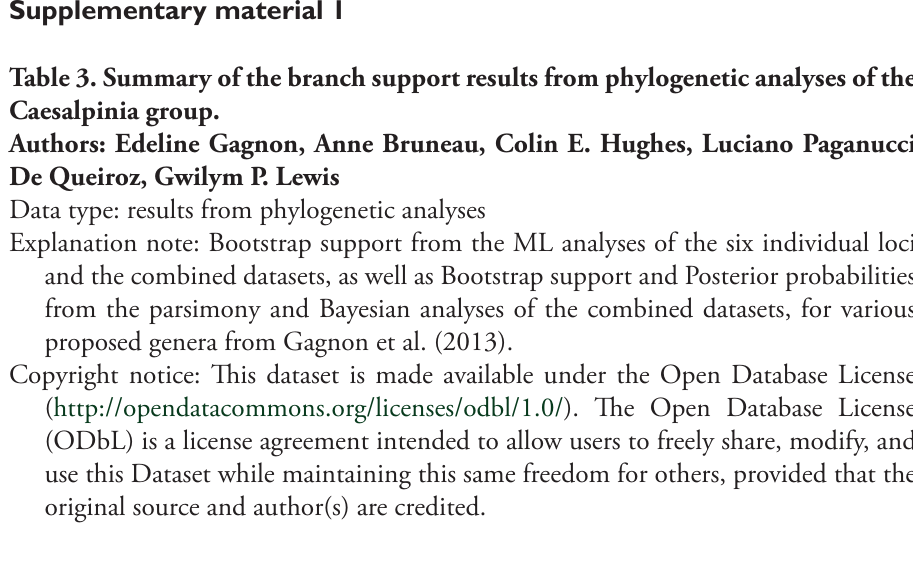
Table 3. Summary of the branch support results from phylogenetic analyses of the Caesalpinia